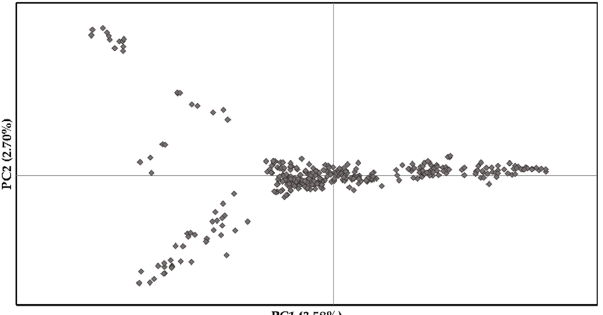
Figure 2. First two principal coordinates revealing the population structure of the S. platyclados half- sib progeny population.